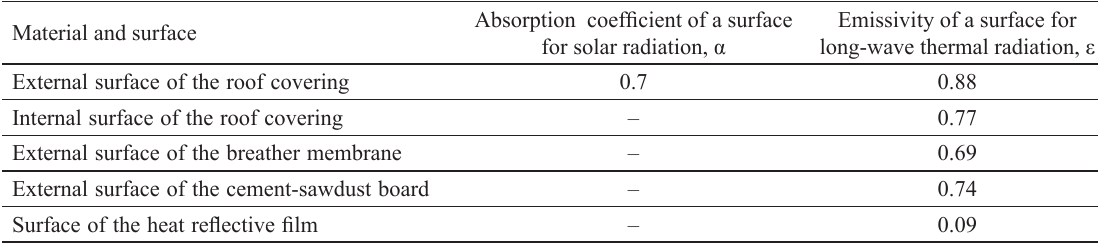
Absorption coefficient of a surface Emissivity of a surface for for solar radiation, α long-wave thermal radiation, ε